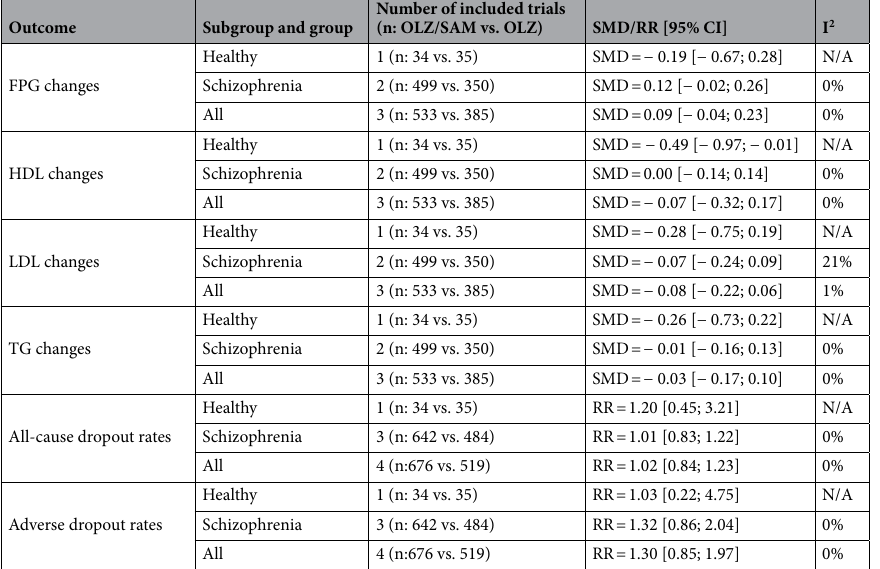
Table 2. Summary of cardiometabolic outcomes and dropout rates. OLZ Olanzapine, SAM Samidorphan, FPG Fasting plasma glucose, HDL High-density cholesterol, LDL Low-density cholesterol, TG Triglyceride, BMI body mass index, SMD Standardized mean difference, RR Risk ratio, N/A not available.